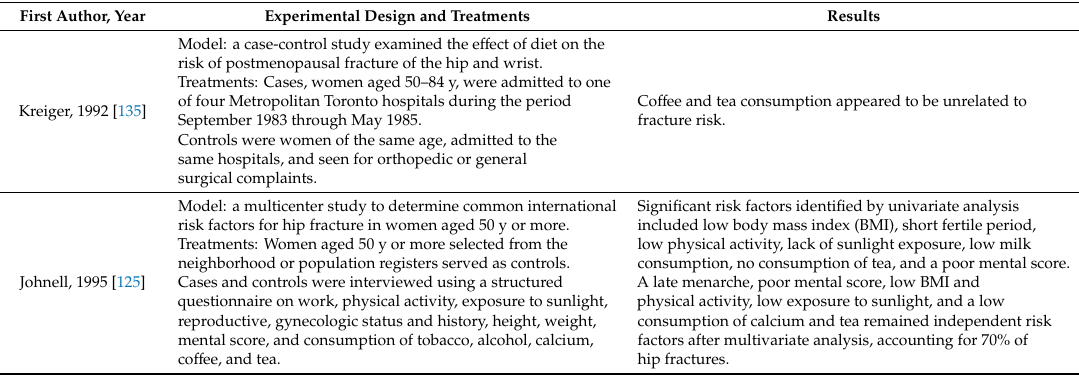
Table 3. Human e ff ects of